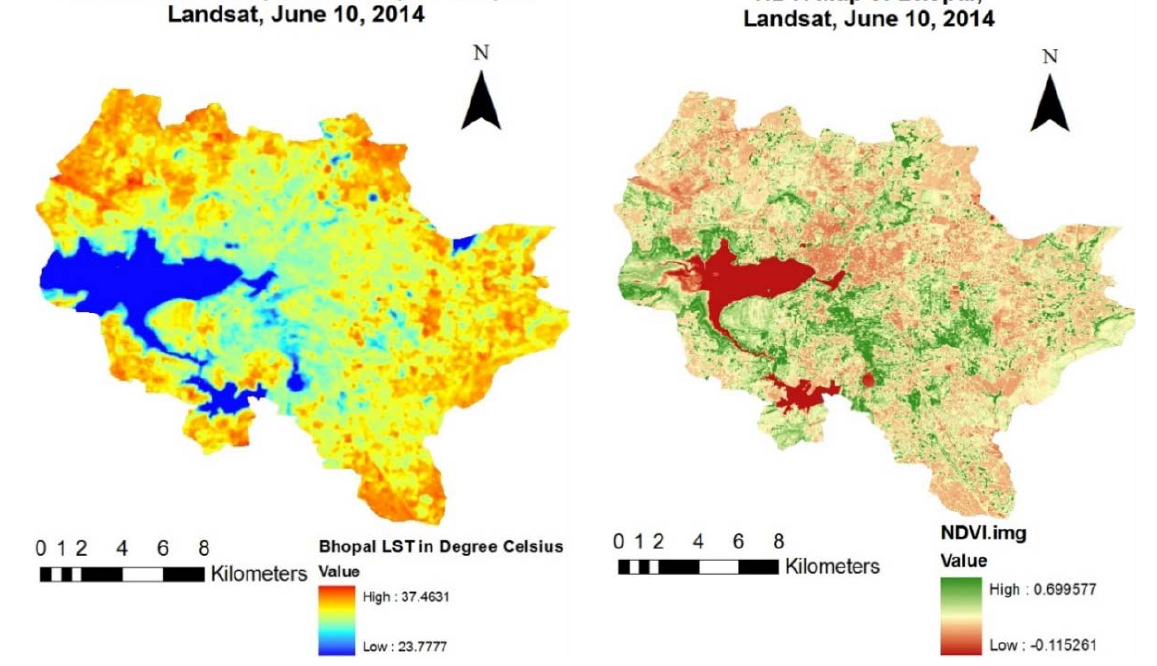
Fig. 3: Land surface temperature (LST) map of Bhopal